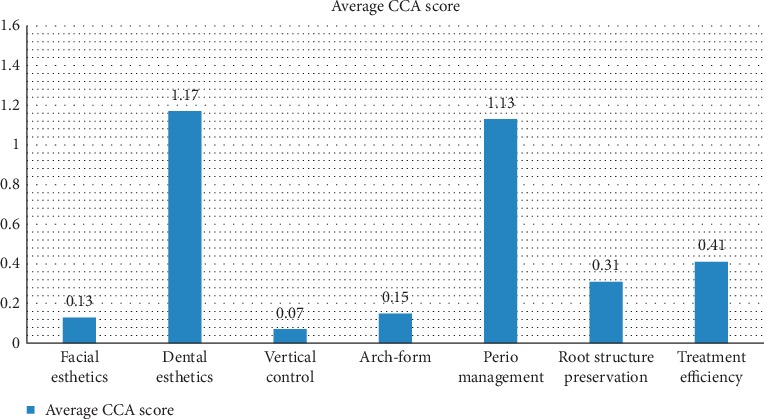
Average CCA score per component.